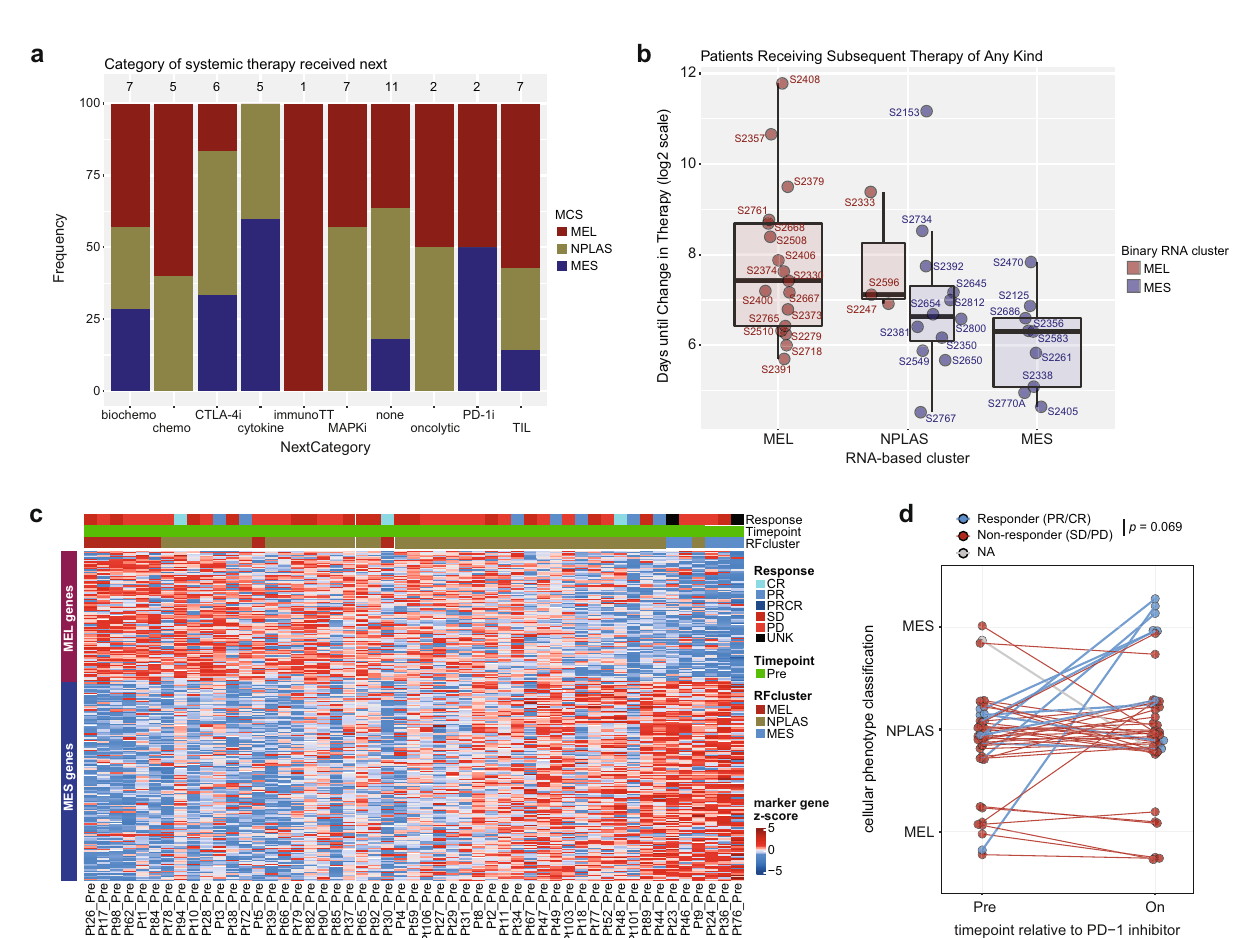
Fig. 7 Clinical associations of MCS. a Systemic therapies received by patients ( n = 53) subsequent to the tumor harvests from which the early passage cell lines were generated, grouped by treatment category. The total number of patients in each category is indicated above each bar, and the MCS of each tumor-derived cell line is indicated in color. b Time, in days, from the initiation of the next line of systemic therapy after cell line-generating tumor harvest, until a further change in therapy was required or last follow-up. Boxplots indicate the median (thick bar), fi rst and third quartiles (lower and upper bounds of the box, respectively), lowest and highest data value within 1.5 times the interquartile range (lower and upper bounds of the whisker), and all individual data points ( n = 41) are shown. c Heatmap of MEL and MES gene expression in pre-PD-1 inhibitor treatment samples of the Riaz cohort, ordered by decreasing MEL-MES score (see “ Methods ” ). Objective response to treatment (Response), sampling time point (Time point; all pre) and random forest model-assigned cluster (RFcluster) are shown for each sample. d Longitudinally sampled patients within the Riaz PD-1 inhibitor cohort revealed a trend towards higher proportion of responders in patients demonstrating a MES-wise shift (i.e. MEL to NPLAS, MEL to MES, or NPLAS to MES) in model-assigned cluster type ( p = 0.069, two-sided Fisher exact test). Source data are provided as a Source Data fi